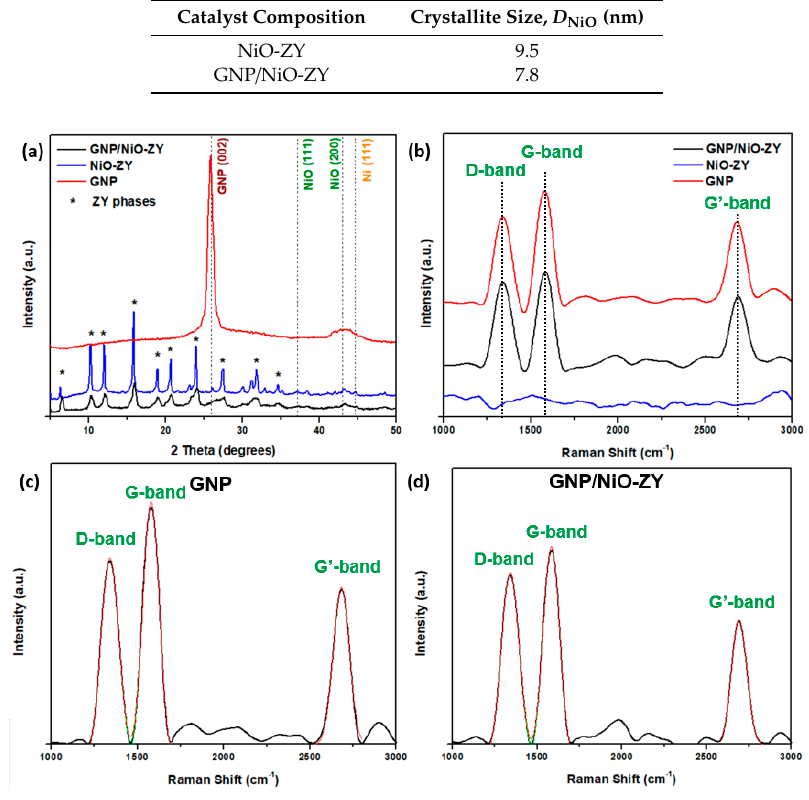
Figure 3. ( a ) XRD patterns and ( b ) Raman shifts of GNP/NiO-ZY, NiO-ZY, and graphene nanoplatelet (GNP), as well as spectral fitting curves of ( c ) GNP and ( d ) GNP/NiO-ZY.